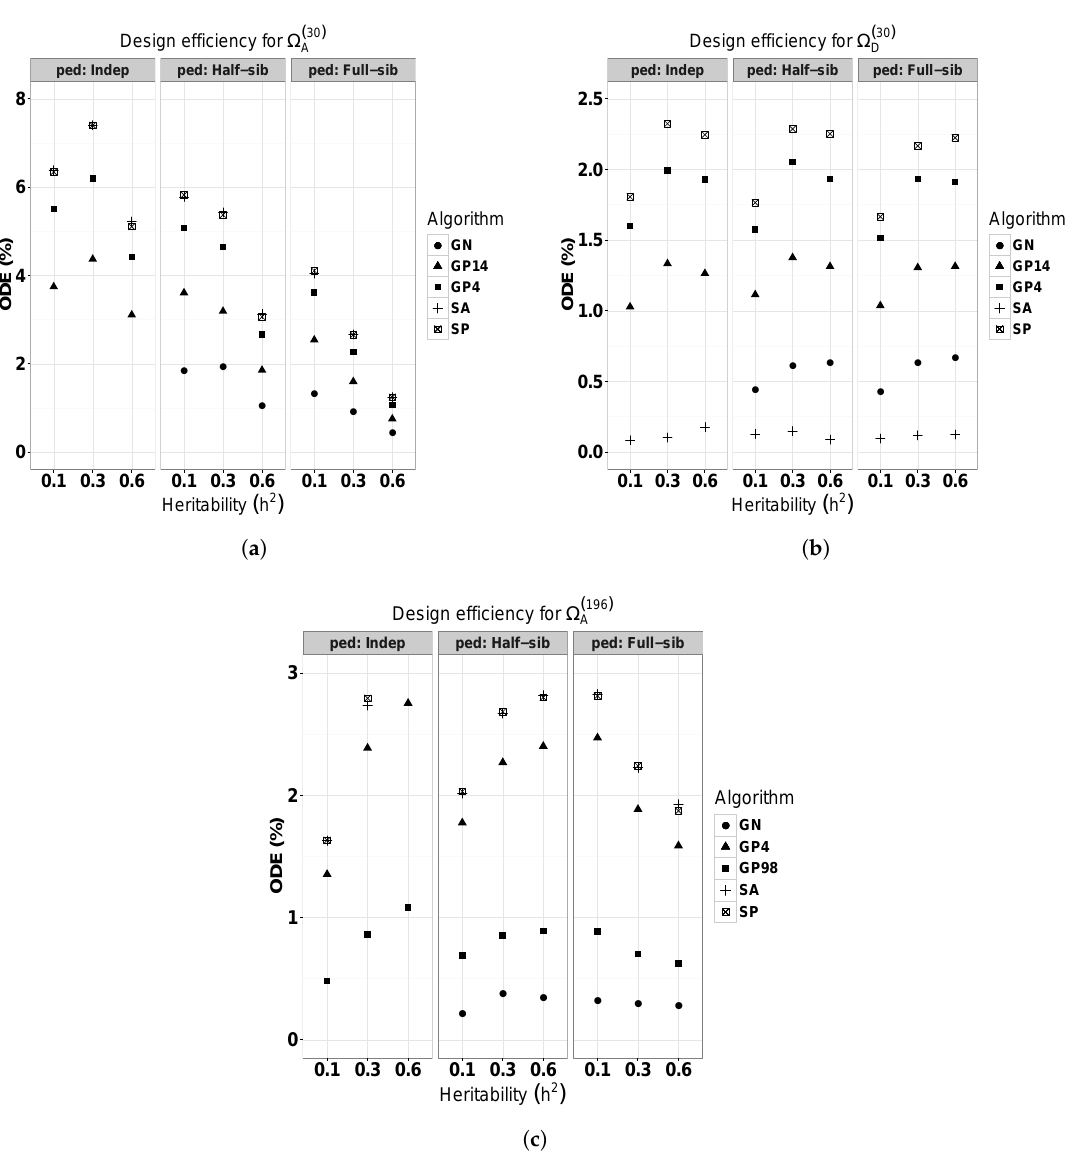
( 30 ) ( 30 ) ( 196 ) , ( b ) Ω , and ( c ) Ω scenarios evaluated D A A